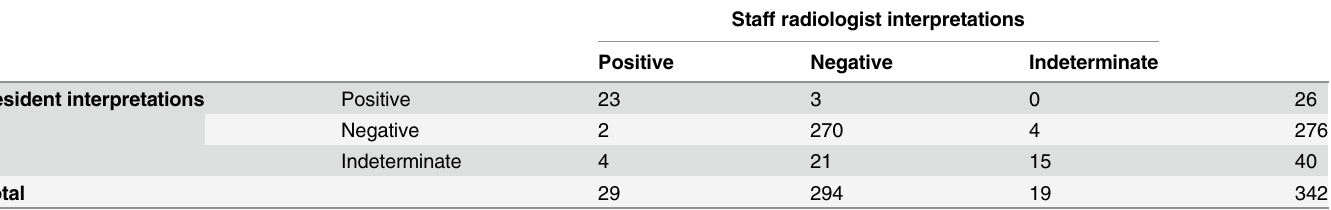
Table 3. Staff radiologists and residents interpretations of CTV regarding the presence of a deep venous